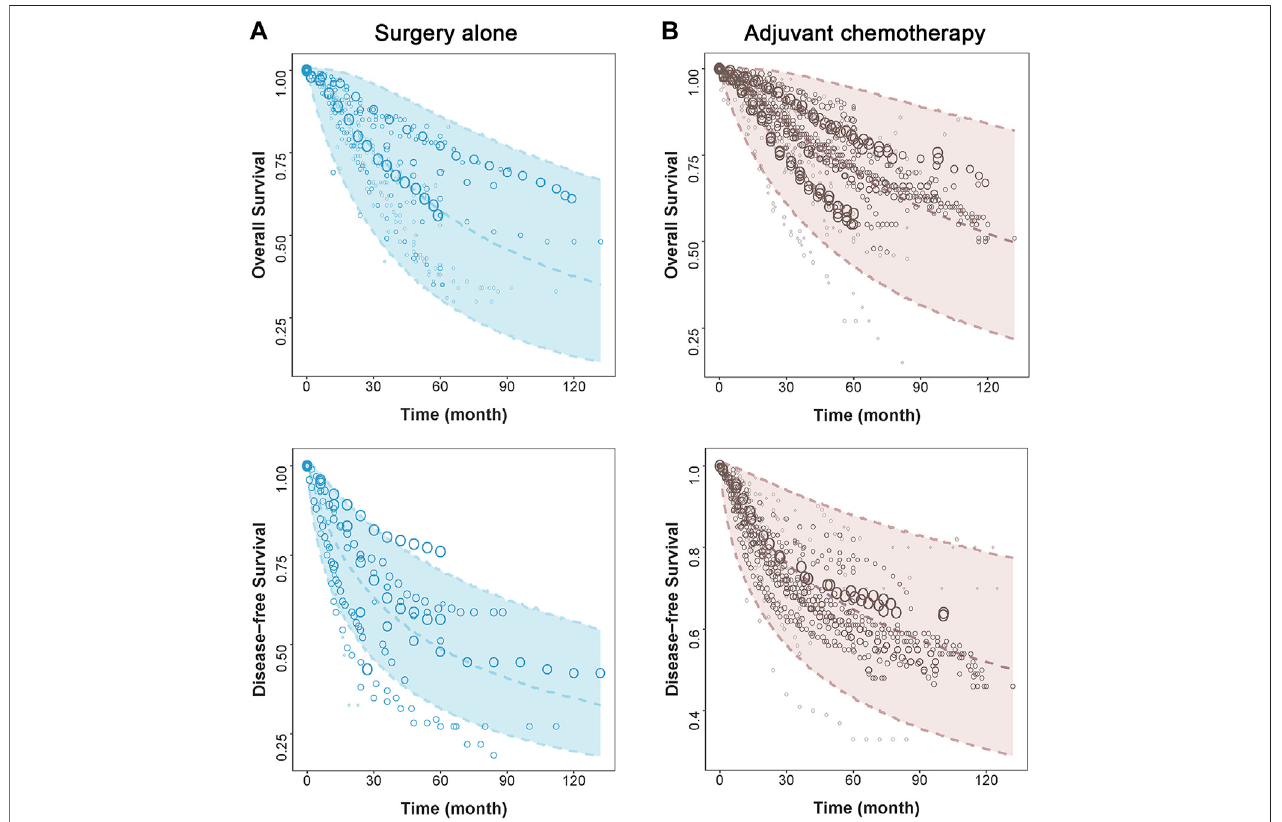
FIGURE1| Visualpredictivecheckofthe fi nalmodel.Thepointsrepresentobservedsurvivaldata,andsymbolsizeisproportionaltosamplesize.Theshadeareais the model predicted 95% CI of the curve. The dashed lines are the model-predicted 2.5th, 50th, and 97.5th percentiles of survival. The two fi gures on the left side represent (A) surgery alone group, and two fi gures on the right side represent (B) adjuvant chemotherapy group.